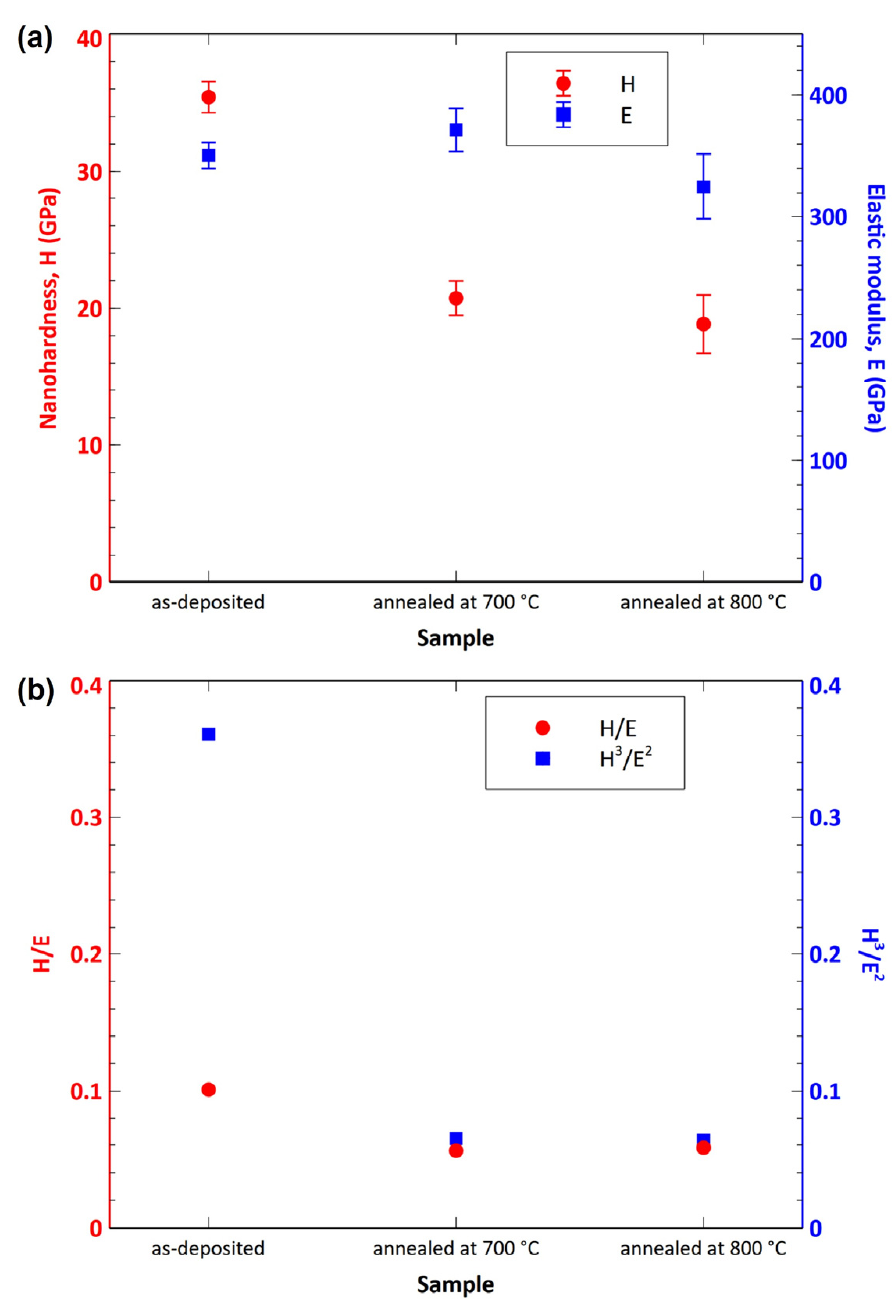
Figure 10. Hardness, elastic modulus ( a ) and the H/E and H 3 /E 2 ratios ( b ) of the studied samples.